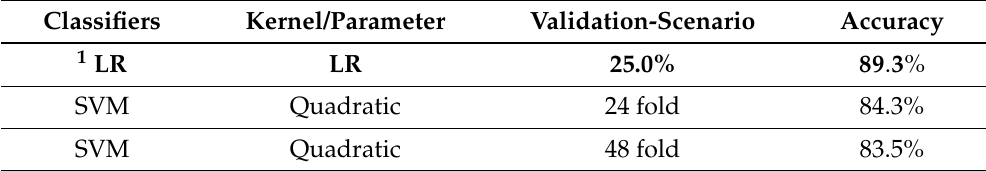
Table 10. The accuracy of classification of different classifiers of the systolic-based sub-experiment (600